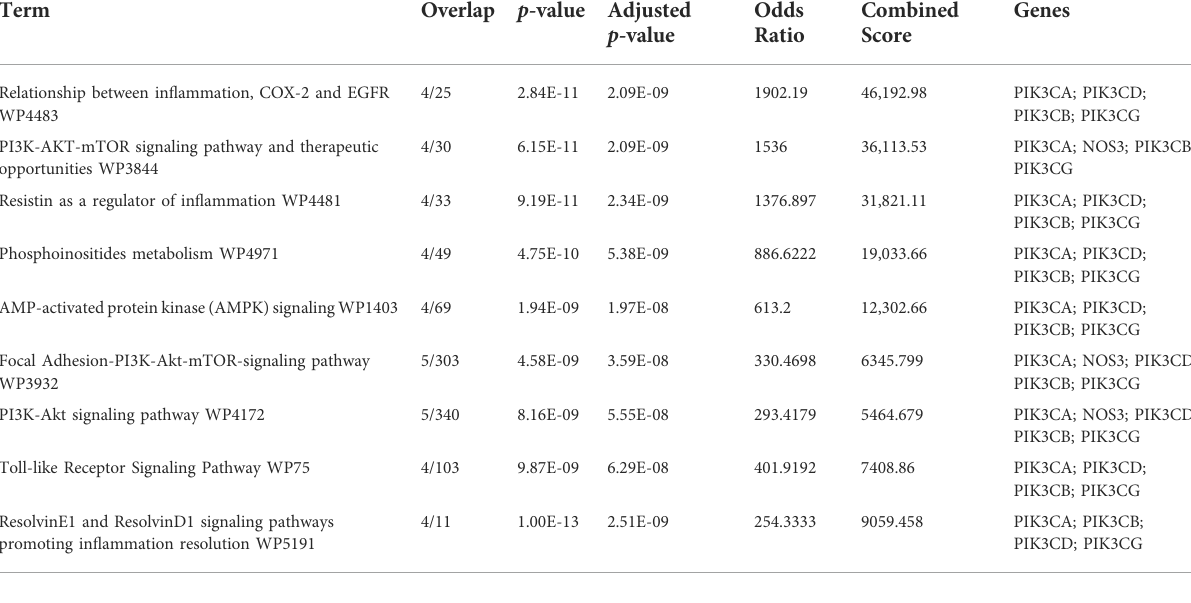
Odds Combined p -value Ratio Score